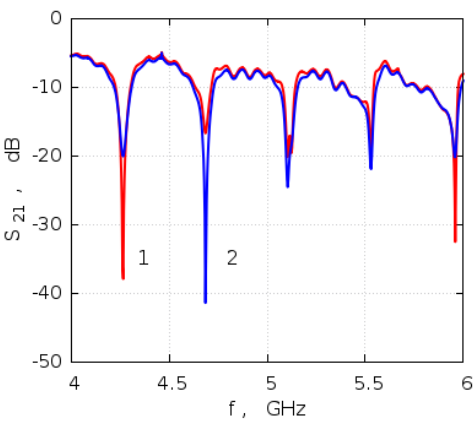
Figure 3: Transmission spectrum of a microwave WGM setup in the dark (curve 1) and in the light (curve